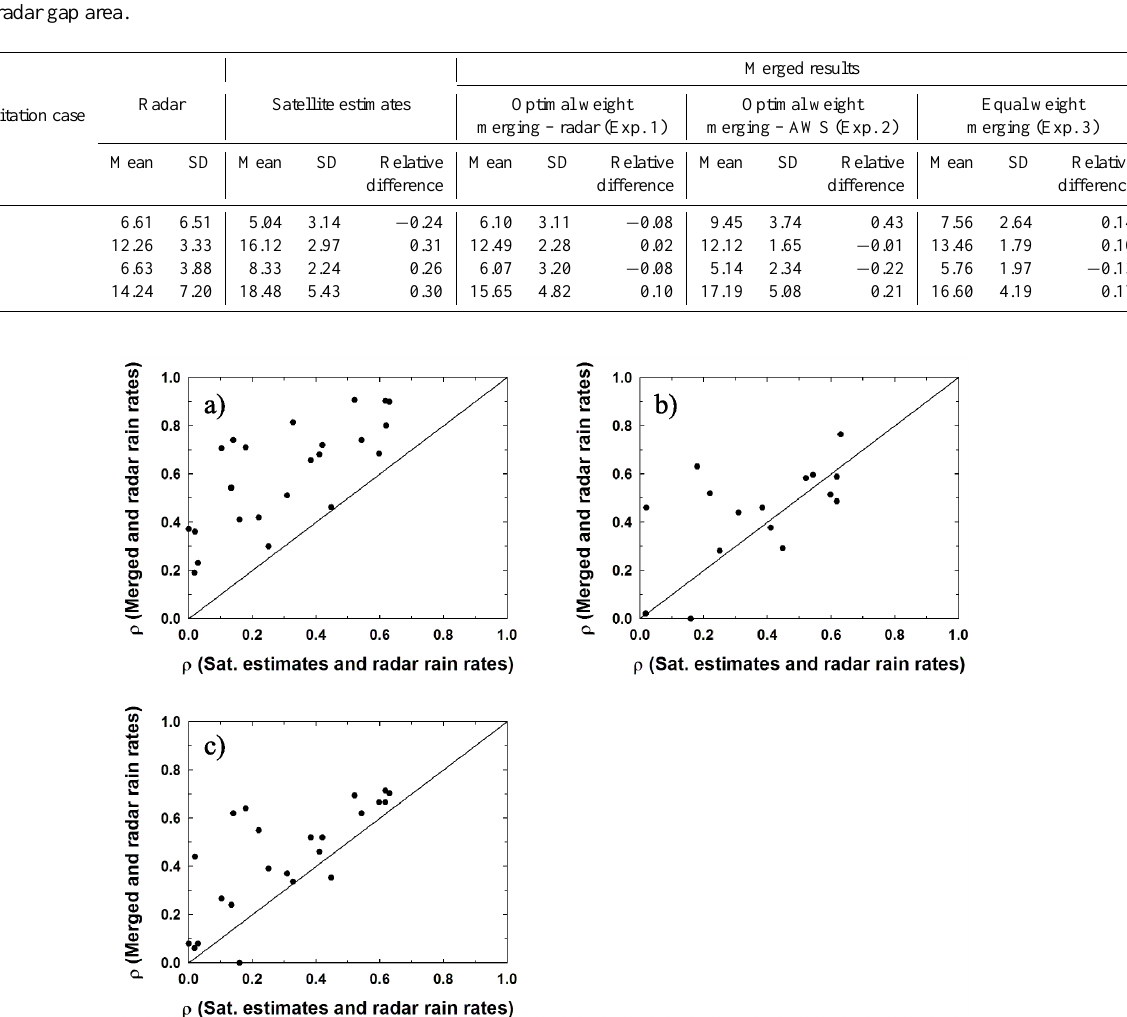
Figure 9. Scatter diagrams of the two correlation coefficients. The first correlation in the abscissa is obtained from the satellite estimates and radar rain rate estimations. The other correlation in the ordinate is from the merged precipitation estimates and the radar rain rate estimations. Panels are classified by the three merged precipitation estimates from (a) optimal weight using radar, (b) optimal weight using AWS, and (c) equal